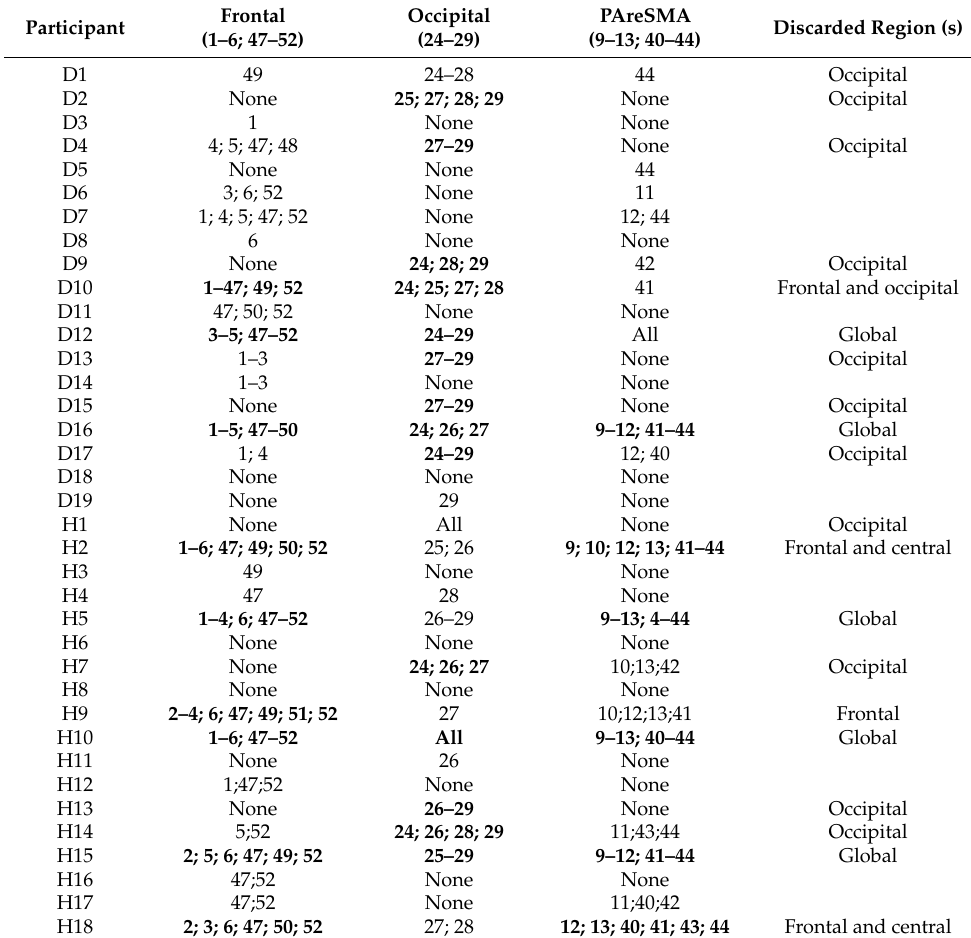
Table 2. Channels discarded by participant and region (see Figure 2 for channel identification). Channels are in bold when they belong to discarded regions (more than 50 % of channels were withdrawn due to